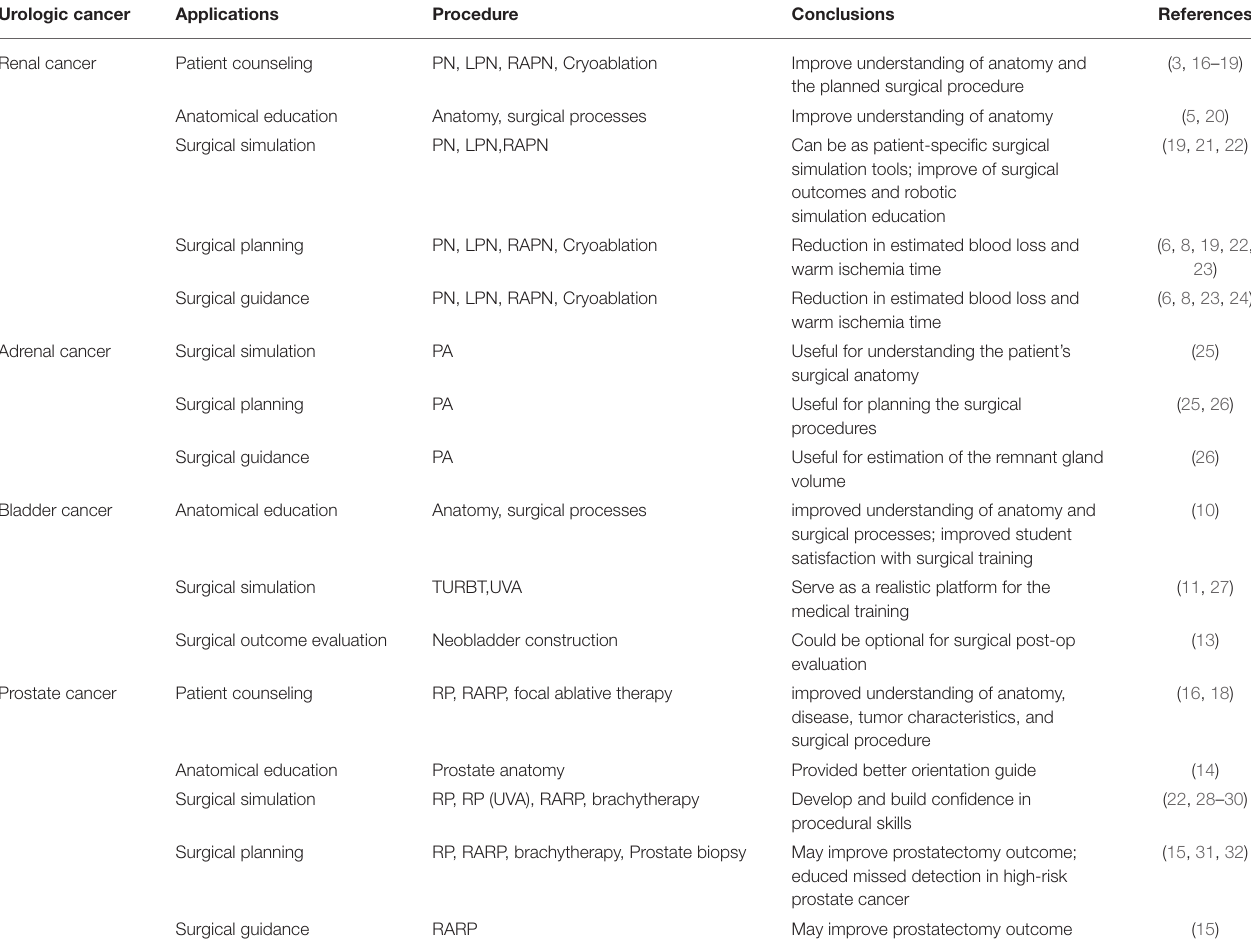
TABLE 1 | Three-dimensional physical model in urologic cancer research. Urologic